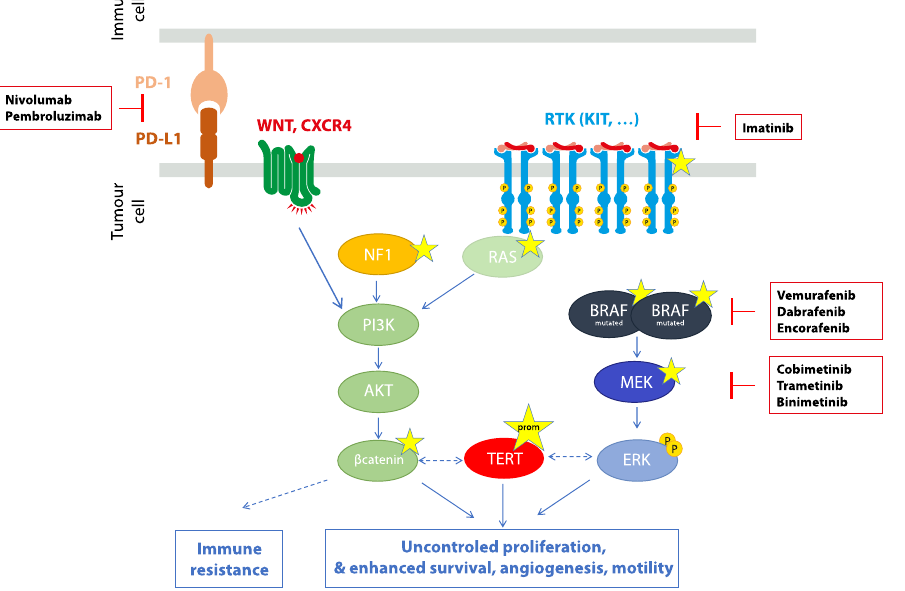
Figure 2. Biological pathways and mutations involved in melanogenesis. Mutations are indicated by yellow stars.